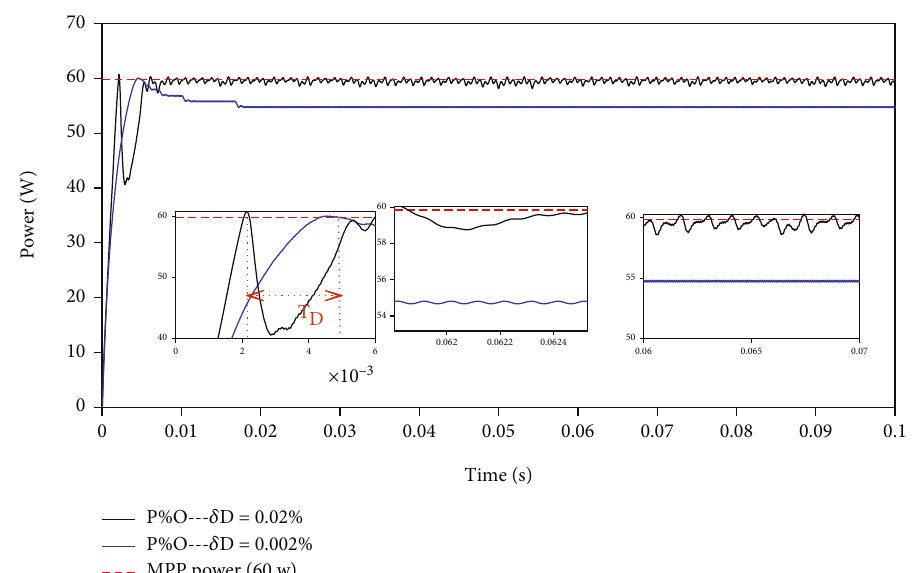
Figure 10: Trade-o ff illustration with the conventional P&O algorithm.